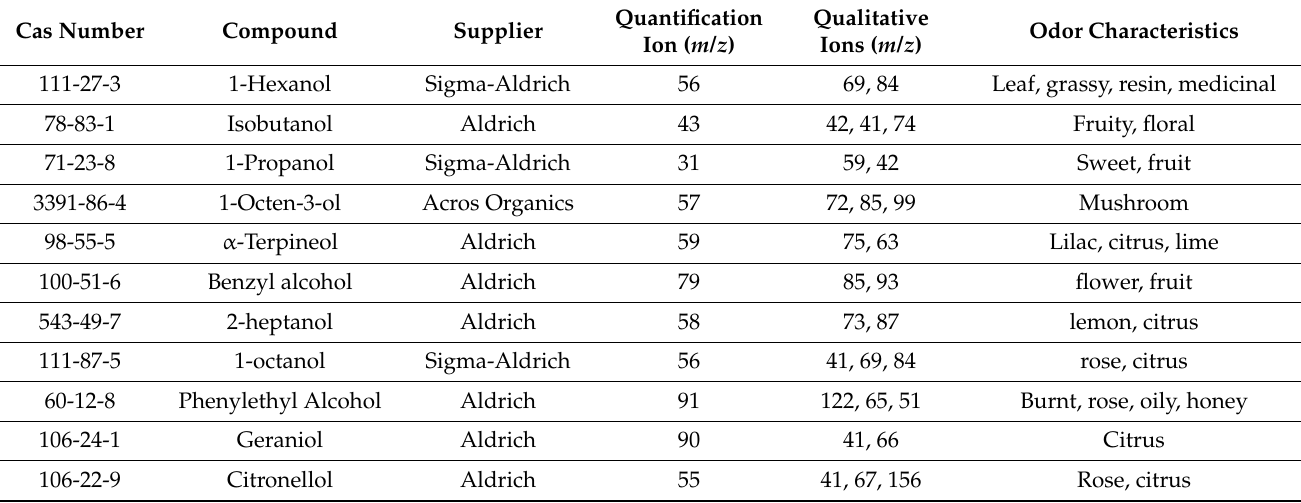
Table 2. Chemical standards and quantitative and qualitative ions for analyzed icewine